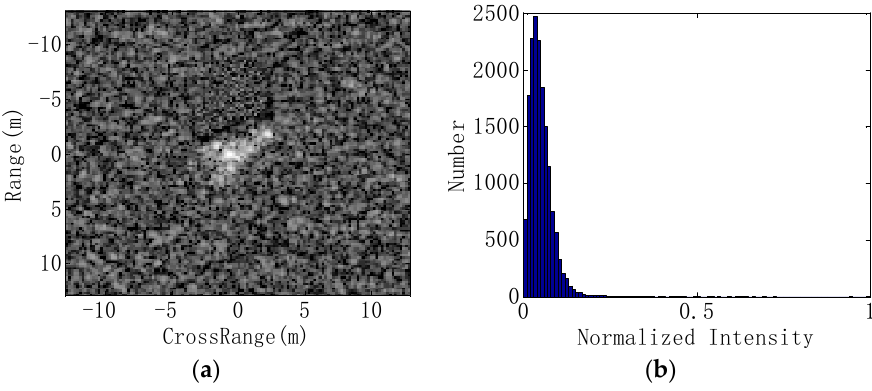
Figure 4. The histogram of the generated target image: ( a ) target image; and ( b ) histogram.